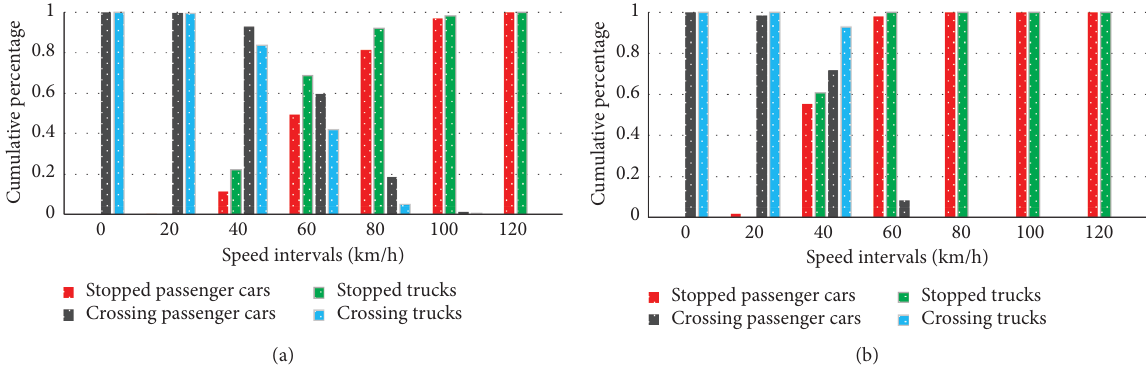
Figure 2: Stop/go decision distribution based on speed intervals. (a) Rural intersections and (b) urban intersections.